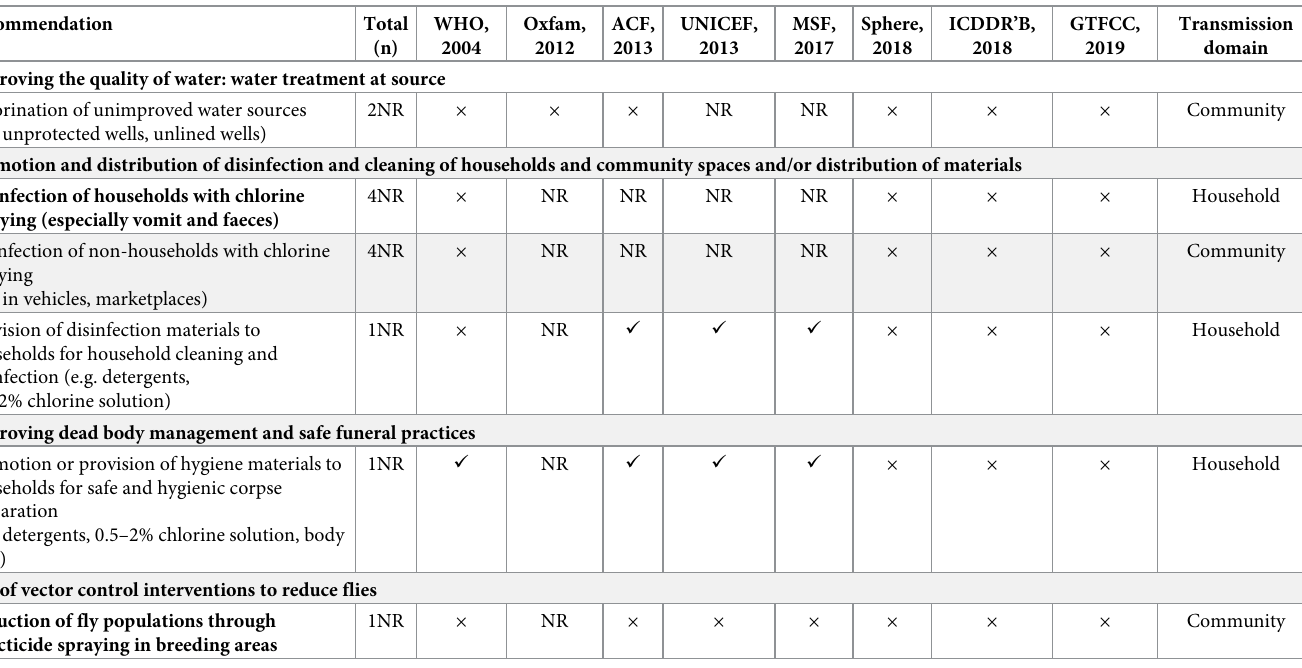
Table 5. WASH interventions not recommended for cholera prevention and control by one or more guidelines.